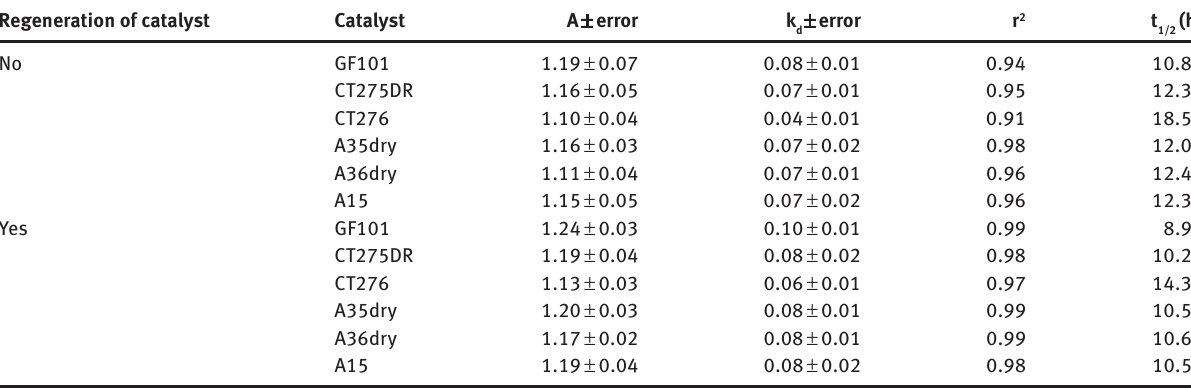
Table 4: Summary of the parameters used for the remaining activity exponential decay model [Eq. (3)] and half-life period for the regenerated and non-regenerated